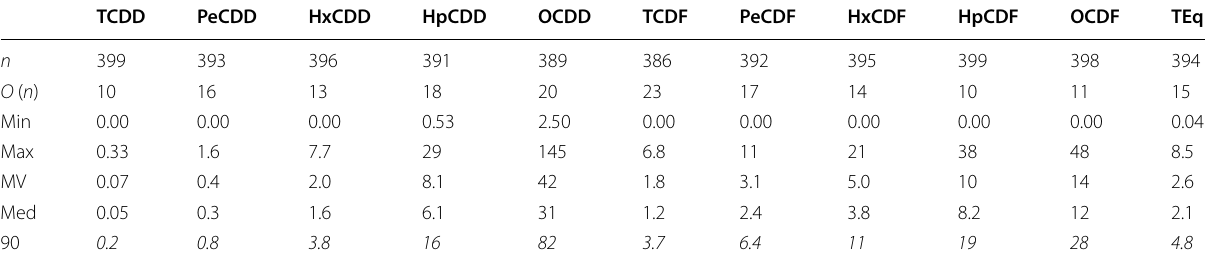
O ( n ), number of outliers; MV, mean value; Med, median; 90, 90%